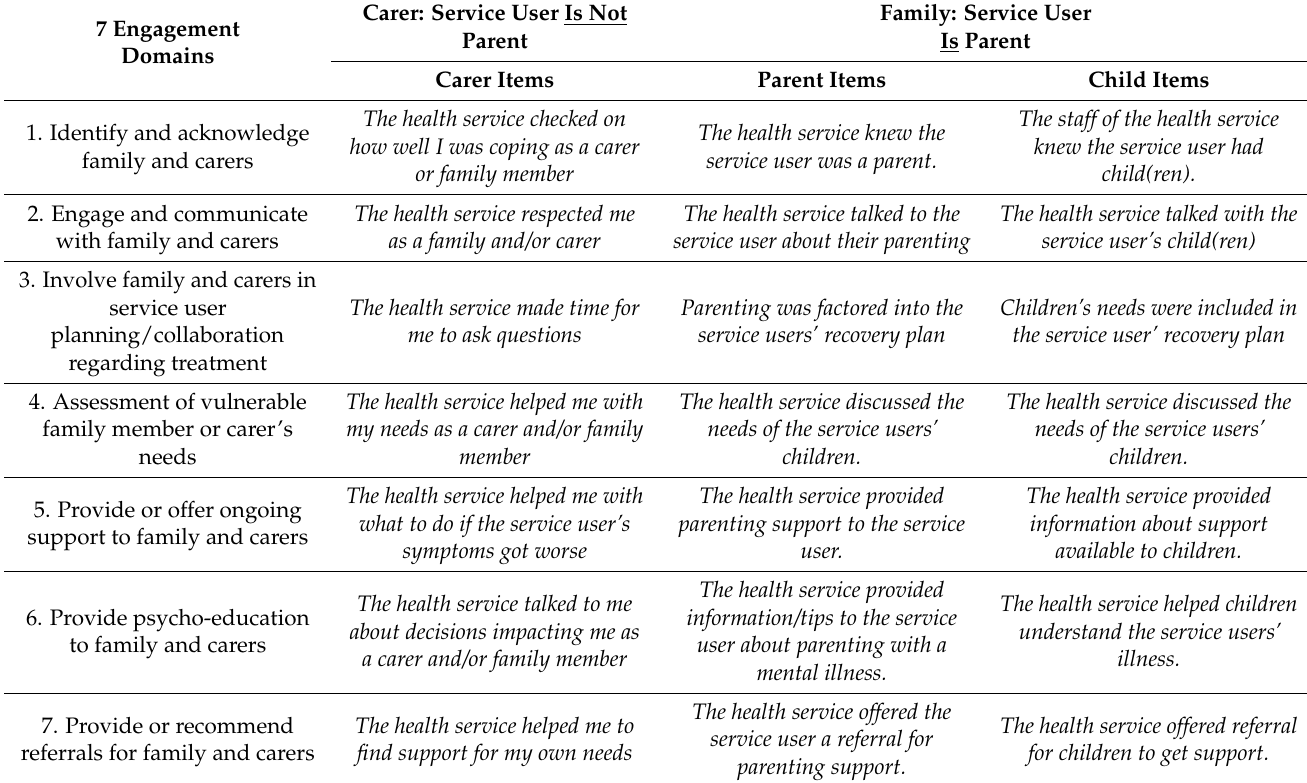
Table 2. Engagement practice domains and items where the service user is and is not a